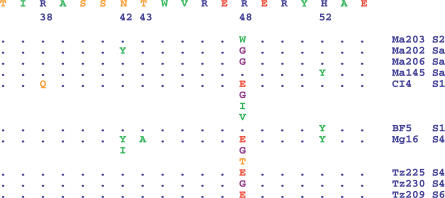
Amino Acid Polymorphism Associated with Virulence in the VPgThe consensus sequence of the wild isolates and the positions of the variable codons are indicated at the top of the figure. Amino acid changes associated with virulence were deduced from comparison between the sequences of the VPg of the wild avirulent and the evolved forms of each isolate. The class of the amino acids is indicated with colors: acidic (red), basic (blue), hydrophobic (green), polar (orange), and small (purple).